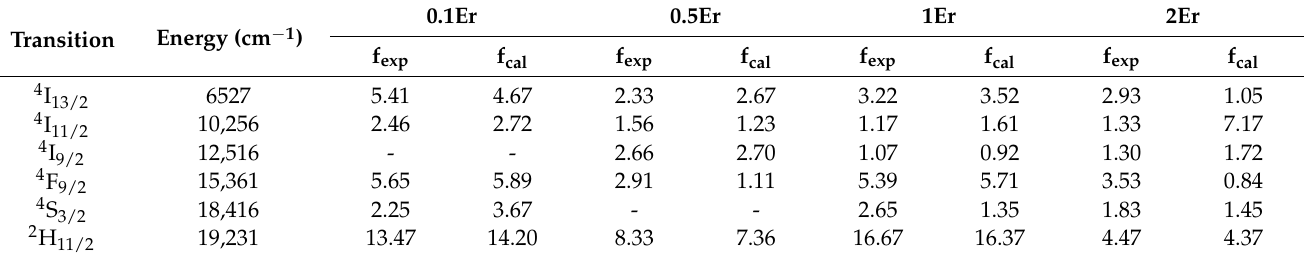
Table 2. Experimental (f exp ) and calculated (f cal ) oscillator strengths (10 − 6 ) of Er 3+ loadedin ZBB glasses.